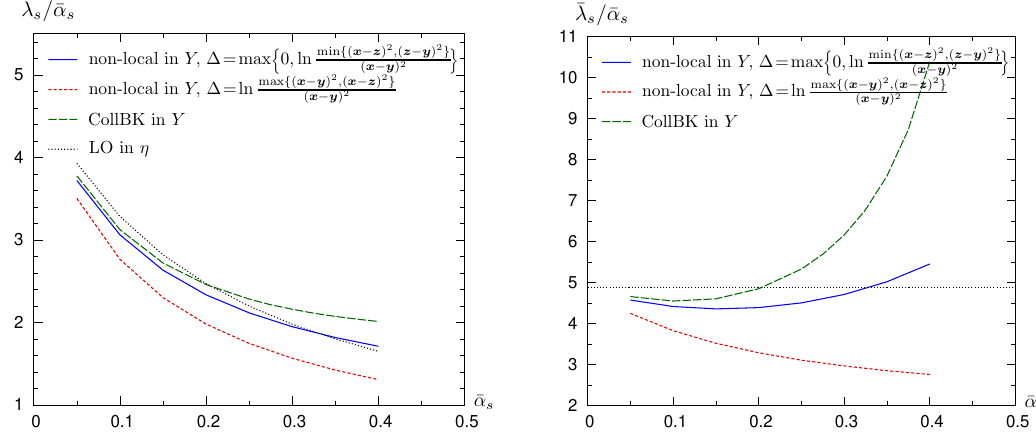
Figure 1 . Left: the asymptotic speed of the front (divided by (cid:22) (cid:11) of (cid:22) (cid:11) s and for three di(cid:11)erent evolution schemes: cf. eq. (3.28) (blue solid curve), eqs. (3.29){(3.30) (red short-dashed curve) and eq. (3.43) (green long-dashed curve denoted as \CollBK in Y "). The black dotted line represents the result of the LO BK evolution in (cid:17) re-expressed in terms in Y . Right: the asymptotic speed of the same fronts when re-expressed in terms of (cid:17) . These results are consistent with eq. (3.34). The LO result (black dotted line) is (cid:22) (cid:21) 0 = (cid:22) (cid:11) s